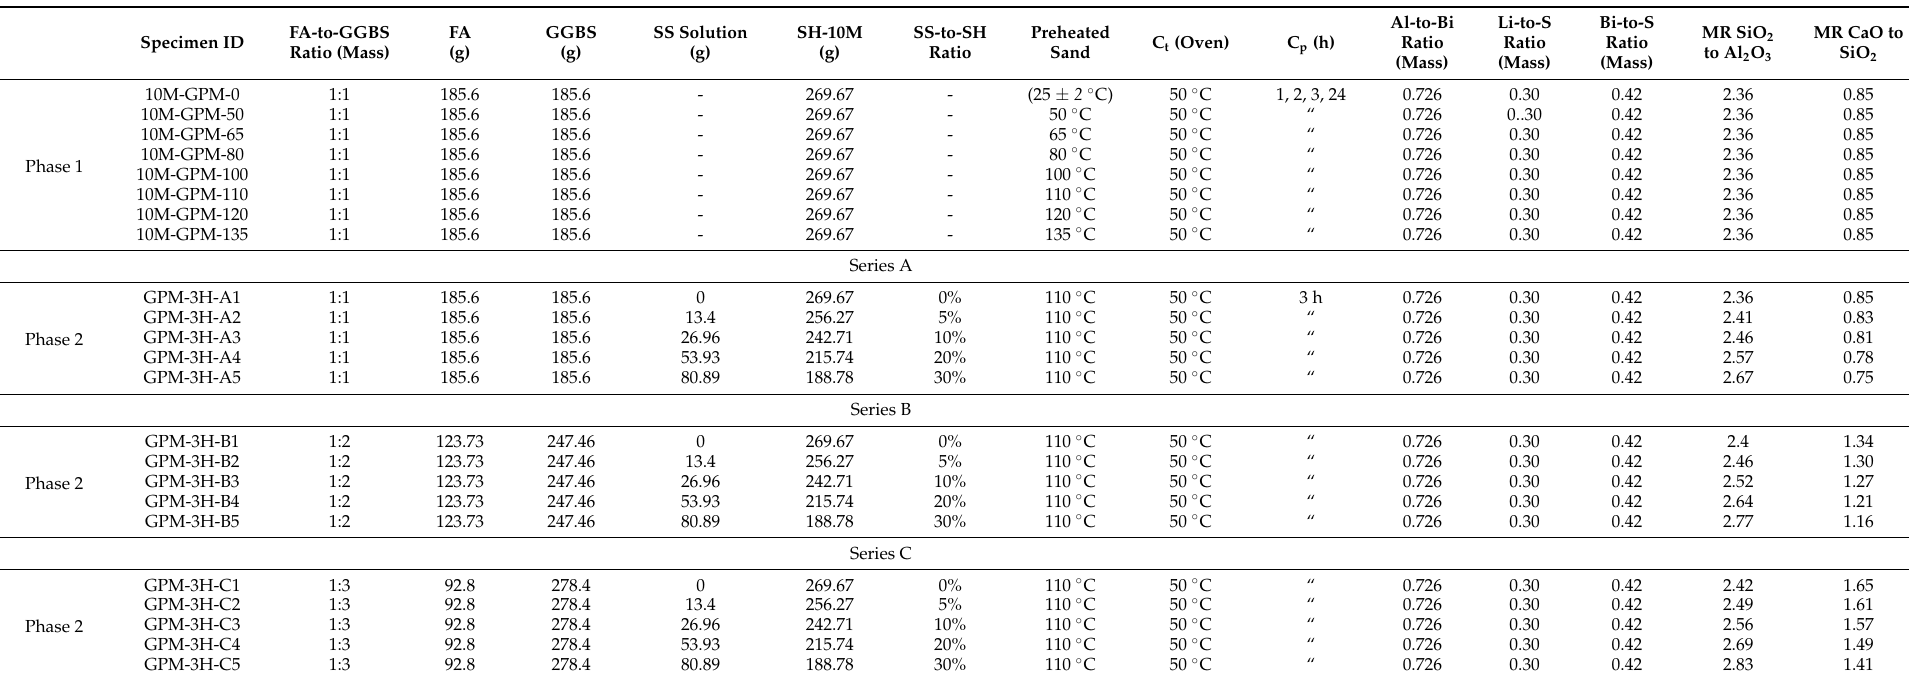
Table 4. Experimental geopolymer material mix proportion by